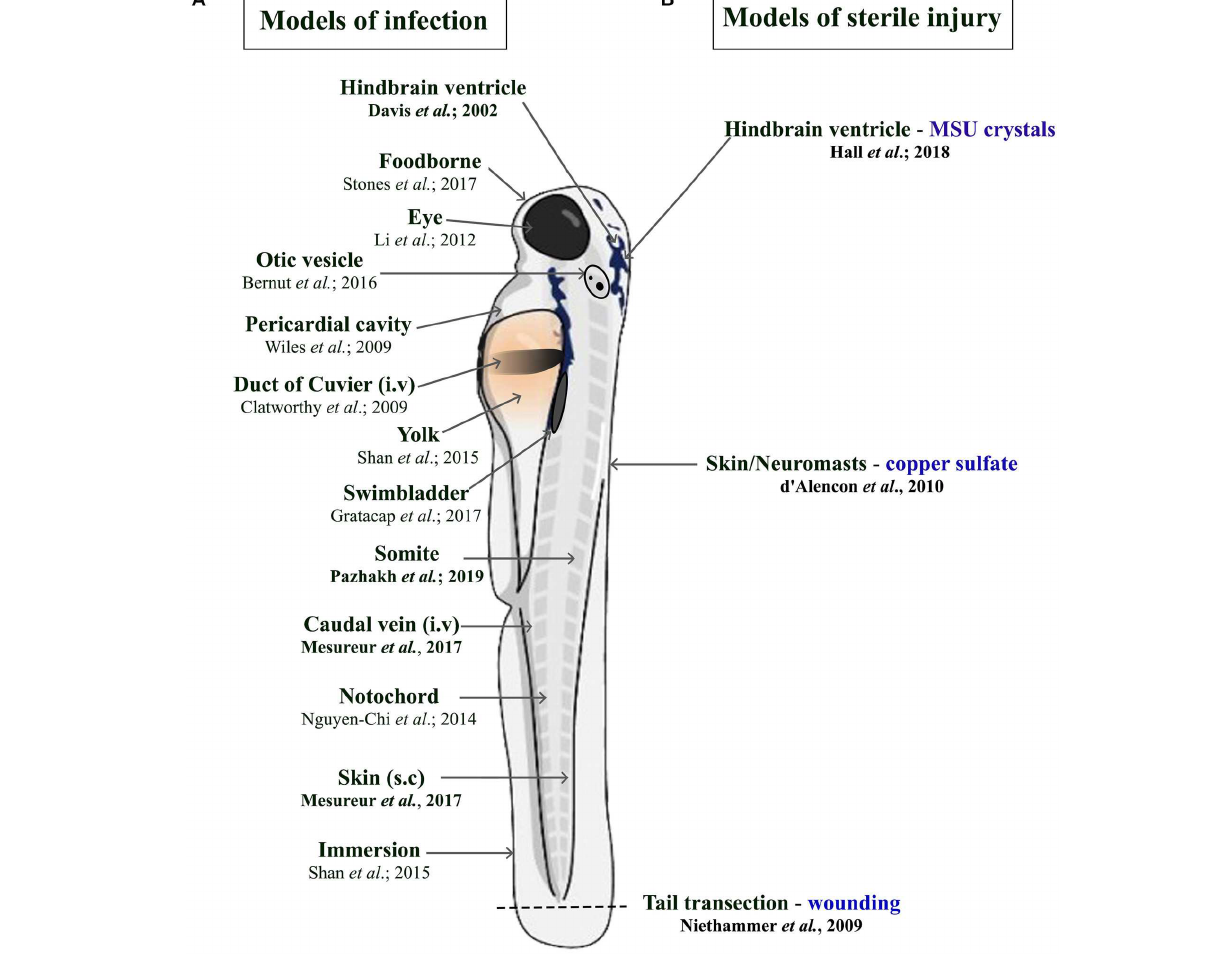
Staphylococcus aureus ( S. aureus ) that show different ways in which the phagocyte response can be host protective or